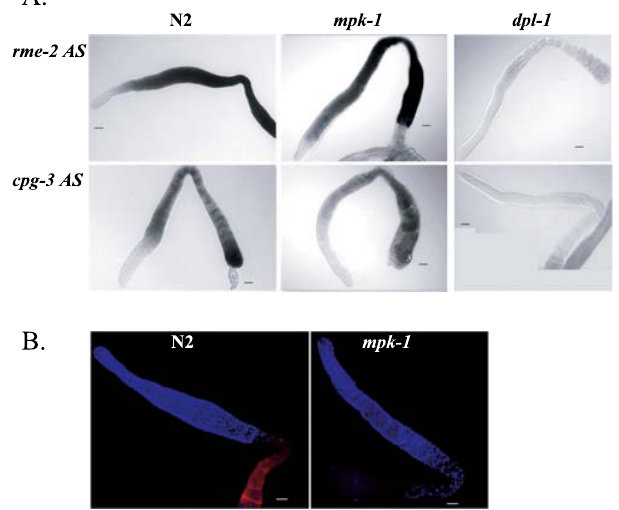
Figure 7. Expression of E2F-Regulated Genes Does Not Require MPK-1 Signaling (A) In situ hybridization of N2, mpk-1, and dpl-1 gonads stained with rme- 2 and cpg-3 AS probes. Sense probes showed no signal. (B) N2 and mpk-1 gonads stained with an antibody to the RME-2 protein (red) and DAPI to mark nuclei